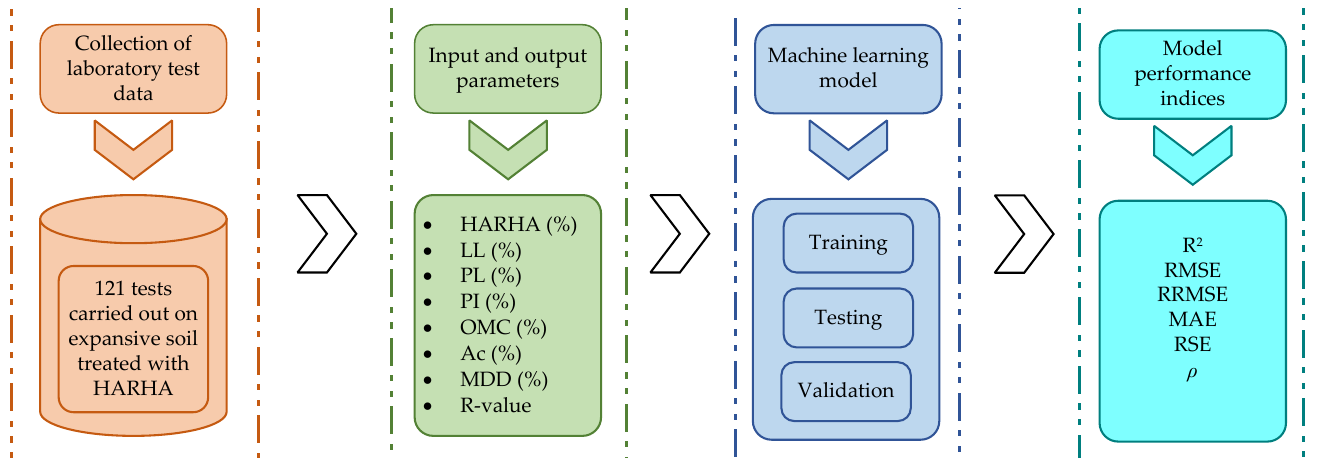
Figure 2. Flowchart for applying ML algorithms to predict the R-value.